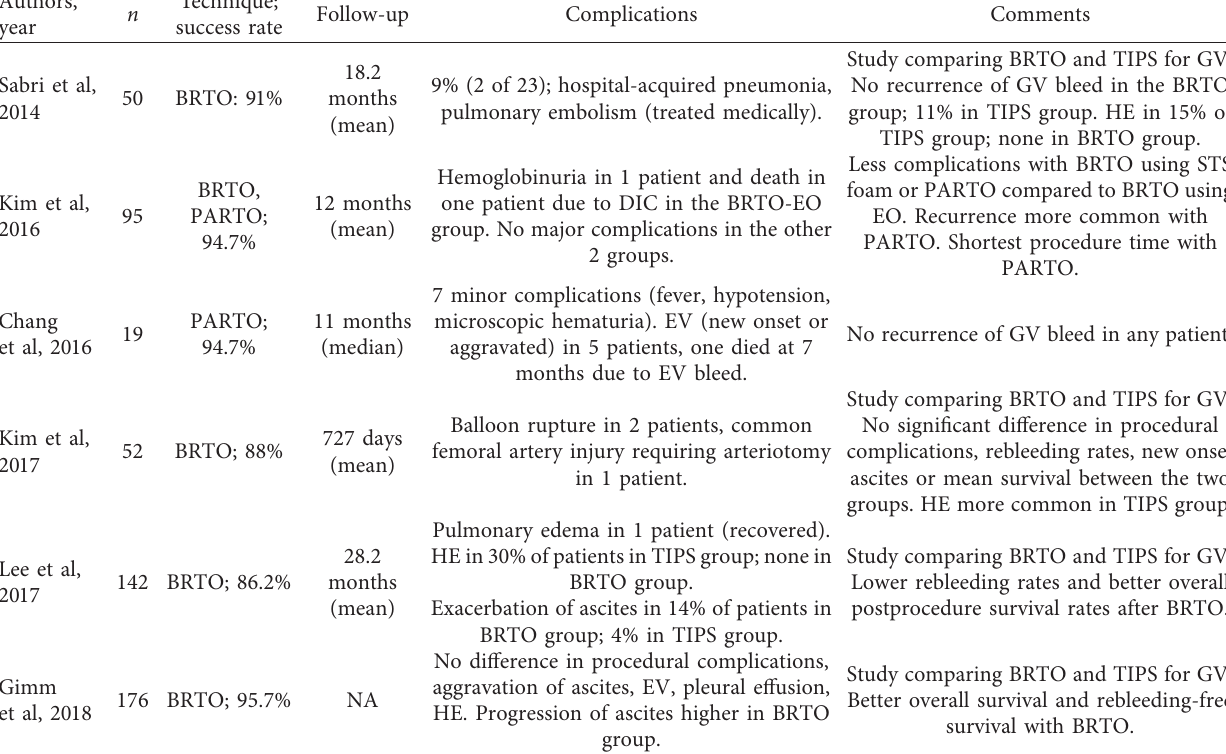
Table 2: Overview of recent studies on efficacy and safety of portosystemic shunt embolization for gastric variceal